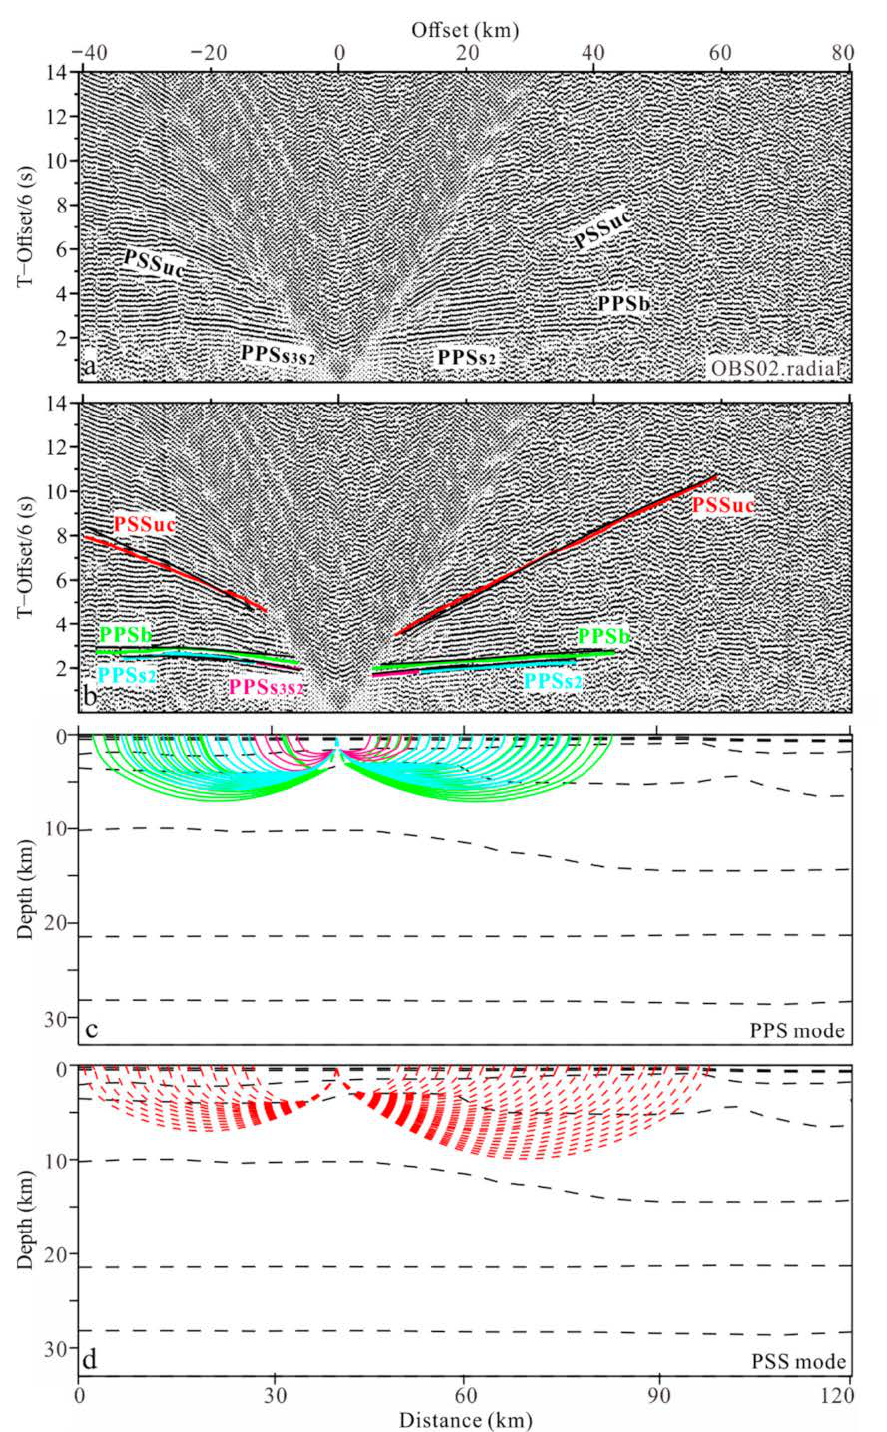
Figure 6. Seismic record section, S-wave phase identification, and ray tracing of OBS 02. ( a ) Seismic profile of radial component. ( b ) The identification and picking of S-wave phases. The coloured lines represent picked travel times and the thin black lines represent calculated travel times. ( c , d ) Show the ray tracing of PPS and PSS conversion modes, respectively. Solid lines represent P-wave paths, dotted lines represent S-wave paths, and the different coloured lines indicate different